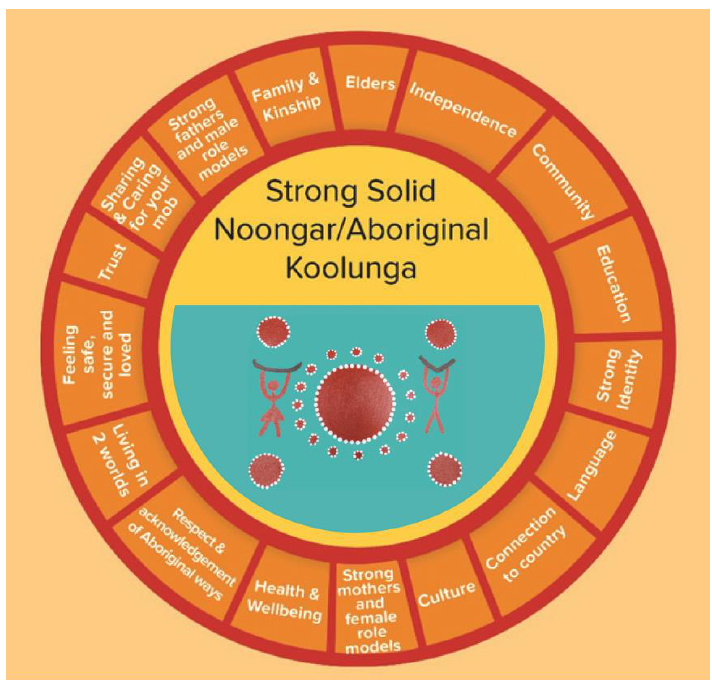
Figure 1. Acknowledging our ways of raising strong, solid Koolunga (Reprinted with permission from the Ngulluk Koolunga Ngulluk Koort project, Telethon Kids Institute).